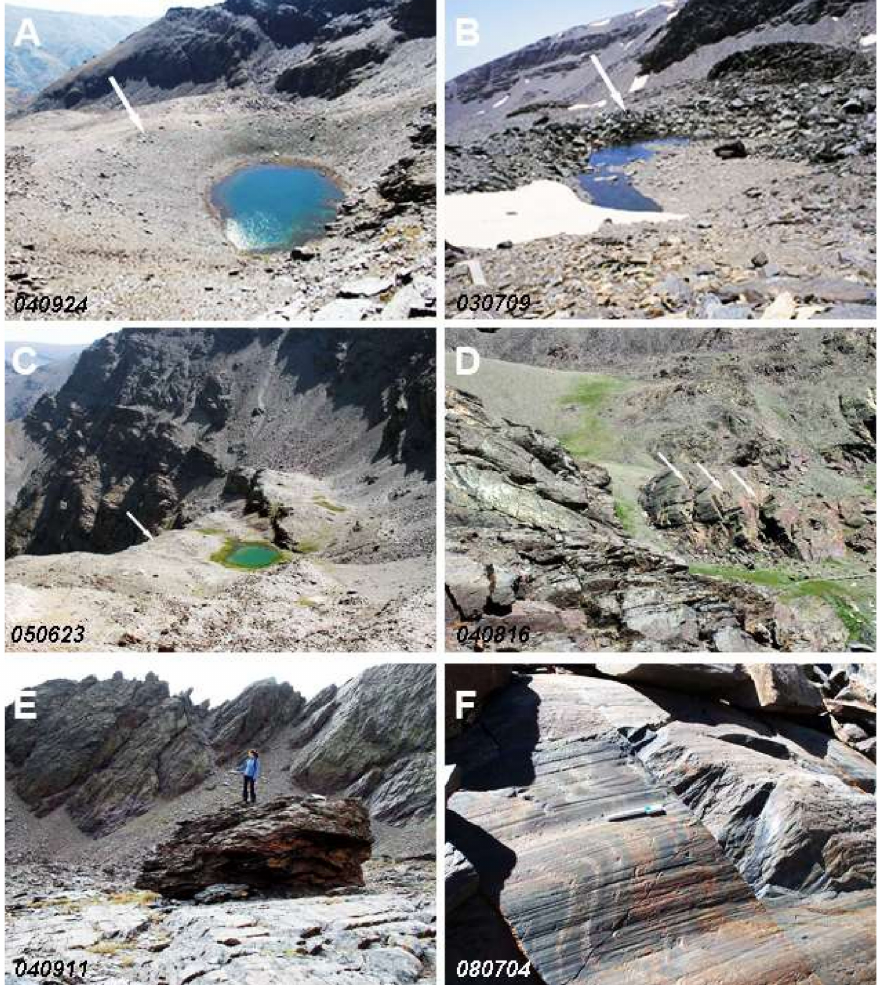
Figure 3. Some glacier morphologies of the area: ( A ) heterometric moraine of Laguna de Vacares, ( B ) rocky moraine and subsequent water-body near Laguna Altera, ( C ) rocky threshold of Laguna de la Mosca, ( D ) fractured and displaced sheepback rock in the Lanjar ó n River valley, ( E ) erratic block near Laguna de Rioseco and ( F ) rock showing glacial striations on polished bedrock in the Valdeinfierno cirque. The numbers in the lower left corner indicate the date of each photograph (year, month,